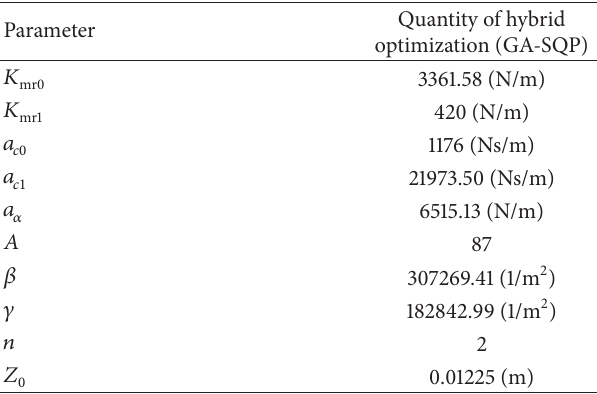
Table 2: Identified parameters of MR damper in 2.5 Hz and zero